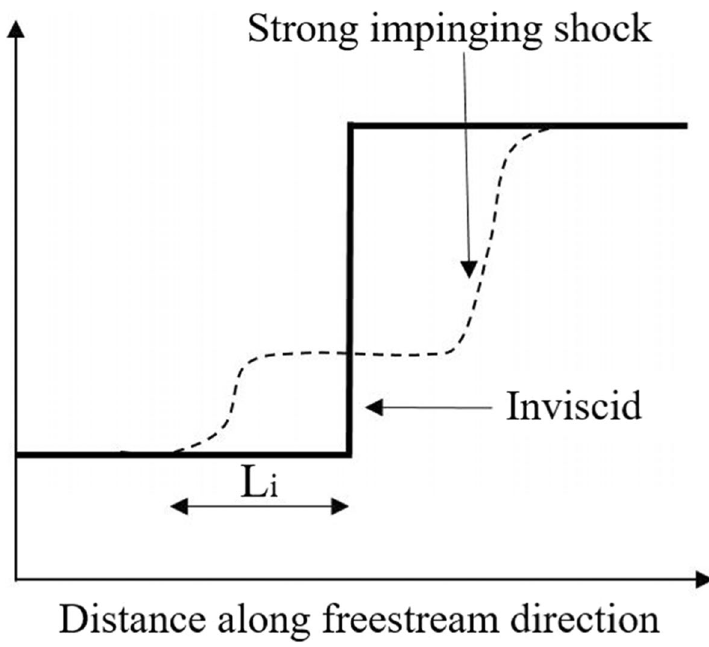
Fig. 4 Wall static pressure distribution for a strong